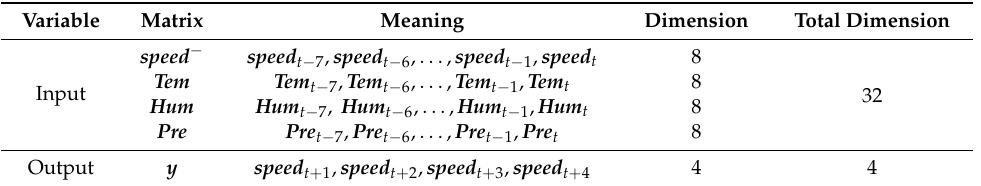
Table 1. Dimensions of the original input and output